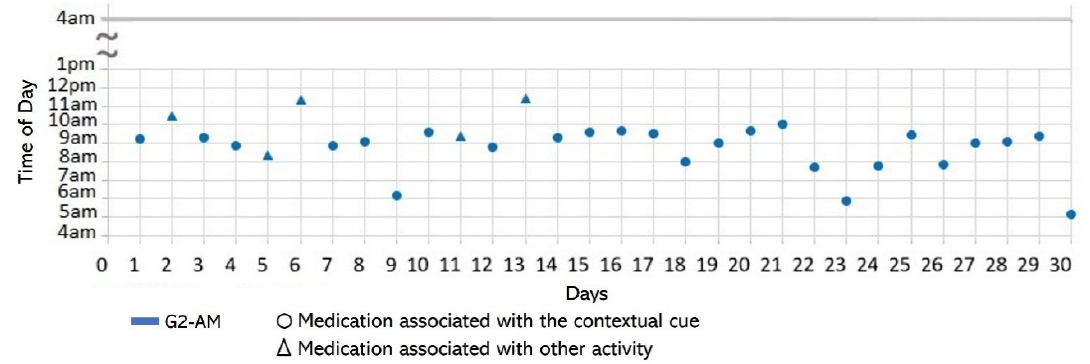
Figure 5. Medication behavior of S2 shows the time of day in which the group of medication (G1) was taken daily and whether it was associated with the activity set as the contextual cue.